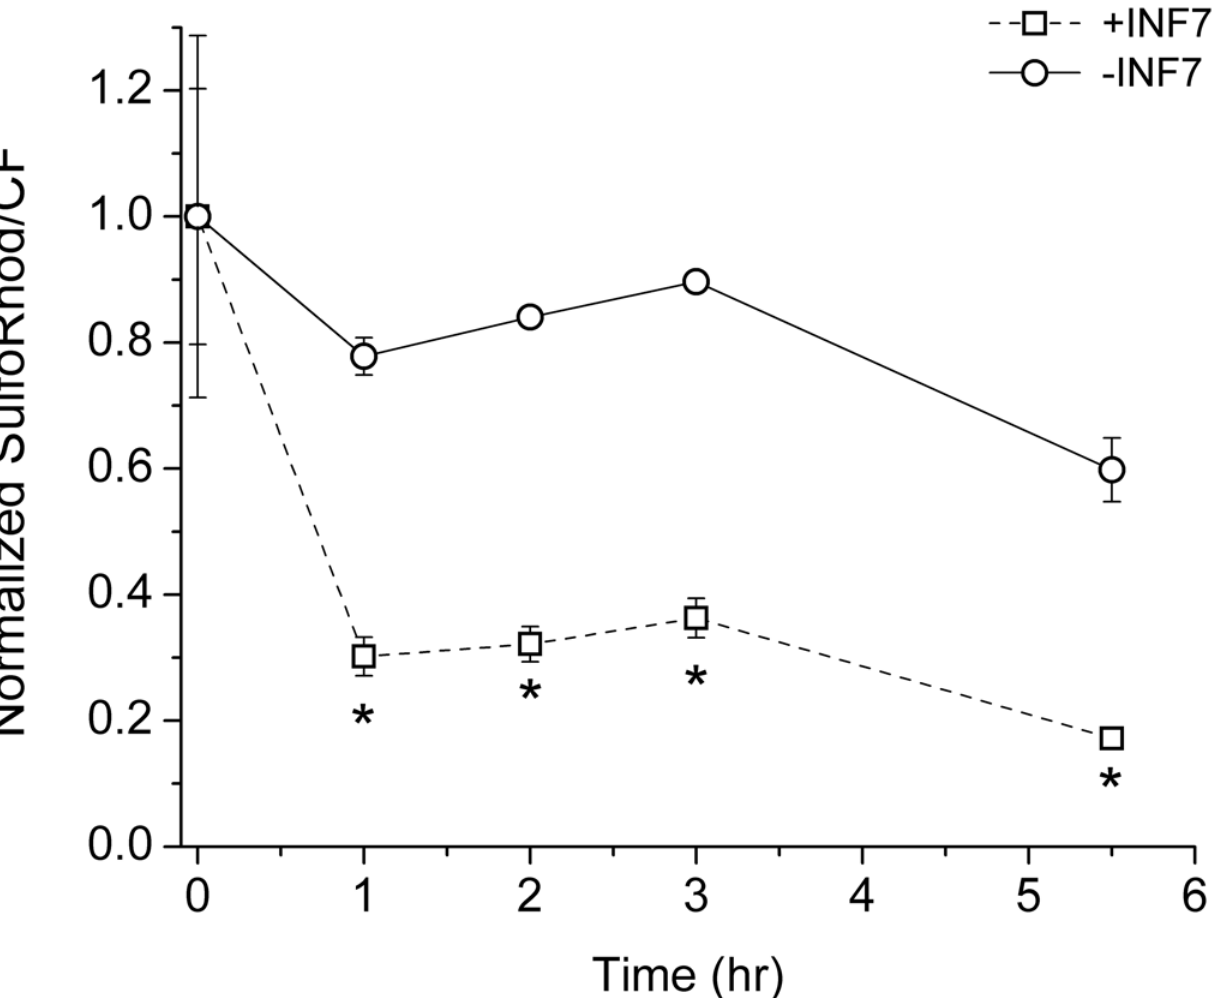
Fig 7. Time course of intracellular SR signal after incubation with liposomes containing or lacking INF7. CV1 cells were incubated with liposomes for 1 hr, washed with Ca 2+ /Mg 2+ -free PBS containing 1 mM EDTA, and allowed to incubate in Ca 2+ /Mg 2+ -containing HBSS without liposomes (time 0). At various time points, cells were trypsinized and lysed ( n = 3 dishes per time point). Lysates were measured for SR and CF-PE fluorescence and the SR/CF-PE ratio was normalized to the value at time 0. SR fluorescence, relative to CF-PE fluorescence, decays more rapidly in cells receiving INF7-containing liposomes compared to cells receiving liposomes without INF7; this reflects rapid extrusion of SR from the cytosol after SR release from endosomal compartments. Asterisks indicate significance ( p < 0.05; two-way ANOVA). Error bars indicate the SEM and are not shown when smaller than the plotted